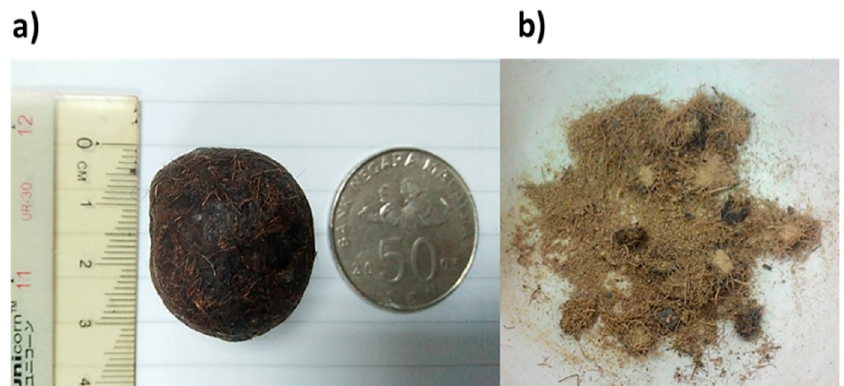
Figure 1. The porcupine bezoar (PB) used in this study. ( a ) PB with a Malaysian 50 sen coin and scale as size reference. ( b ) A PB after being crushed consists of a mixture of rough powder and undigested fiber.